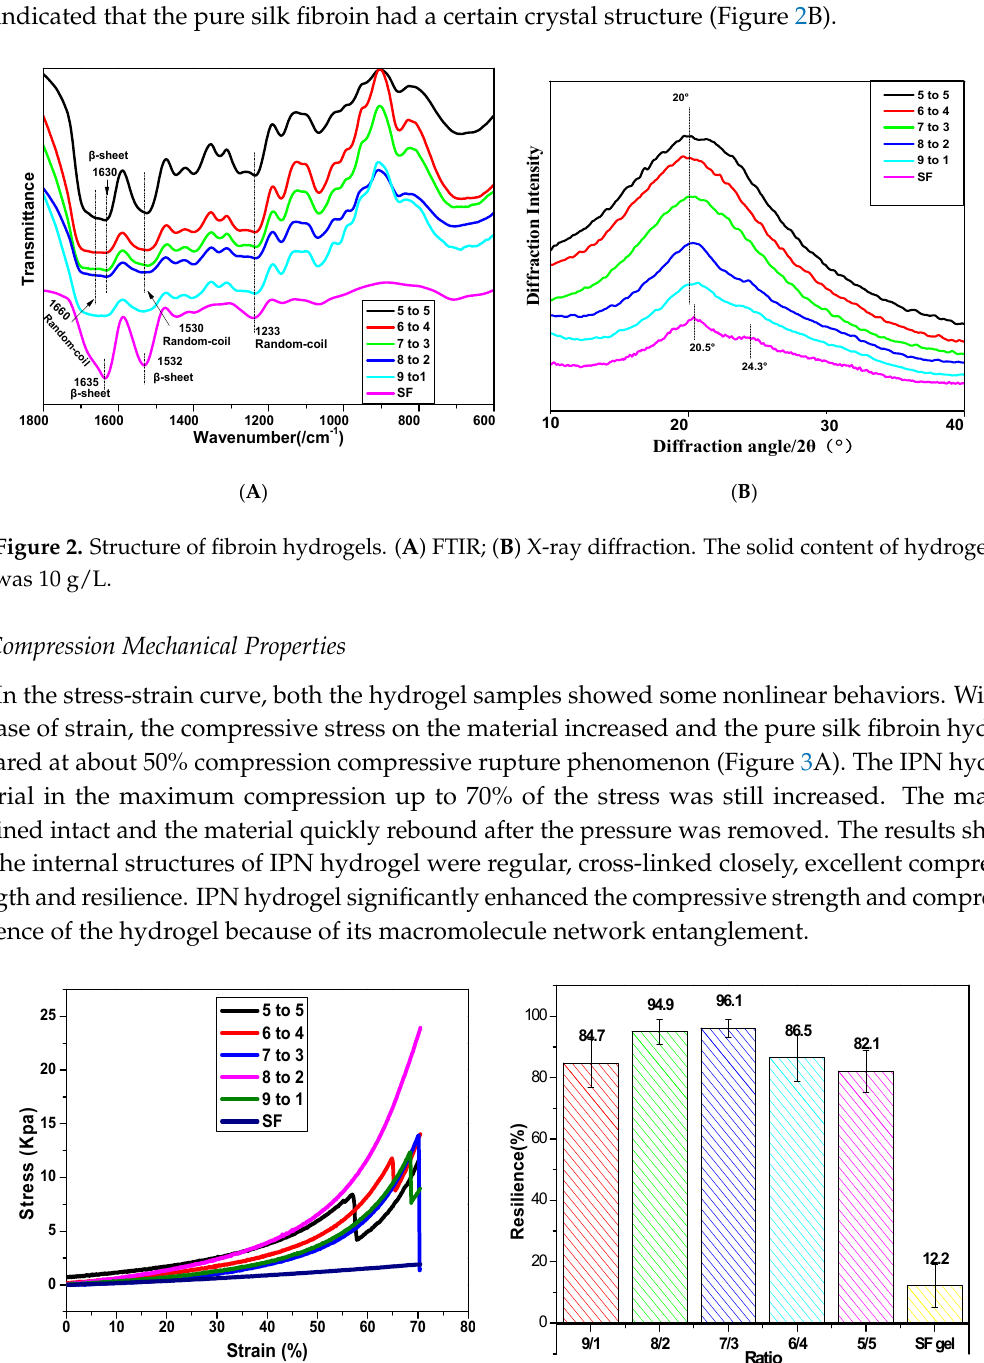
Figure 3. Compression mechanical properties. ( A ) Stress-strain curves of PVP-SF IPN hydrogels. ( B ) Stress resilience of PVP-SF IPN hydrogels. The solid content was 10 g/L, the temperature was 25 °C and the relative humidity was 65%.